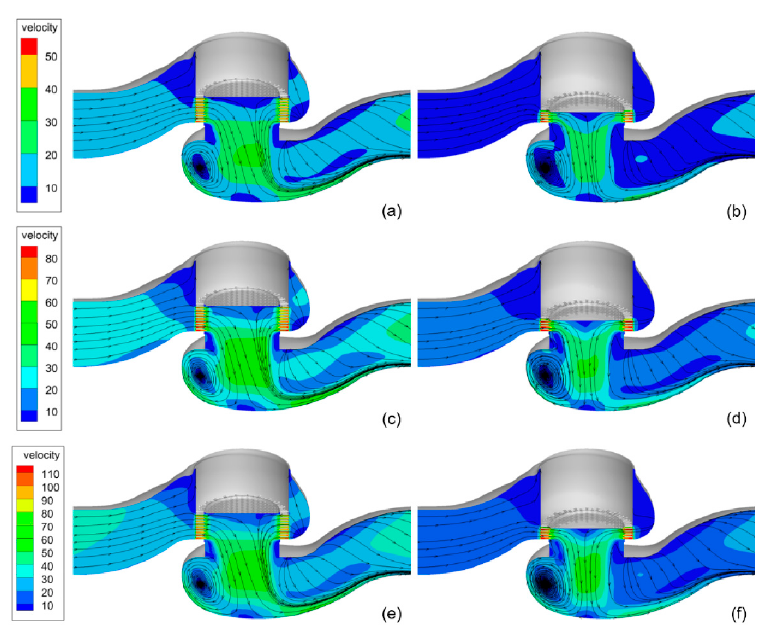
Figure 8. Velocity contours inside the sleeve regulating valve with valve core displacement of 60 mm and 30 mm (m / s) ( a ) 2 MPa, 60 mm; ( b ) 2 MPa, 30 mm; ( c ) 5 MPa, 60 mm; ( d ) 5 MPa, 30 mm; ( e ) 8 MPa, 60 mm; ( f ) 8 MPa, 30 mm.